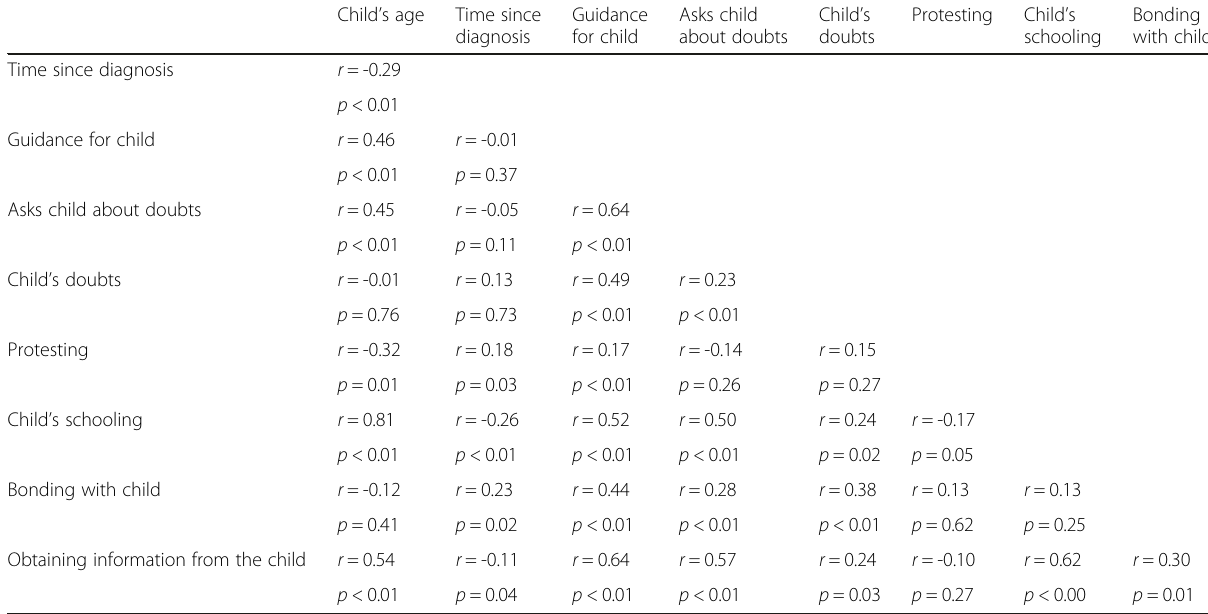
Table 2 Correlations between Sociodemographic and Clinical Dimensions and Pediatrician ’ s Communicative Behaviors towards the Child